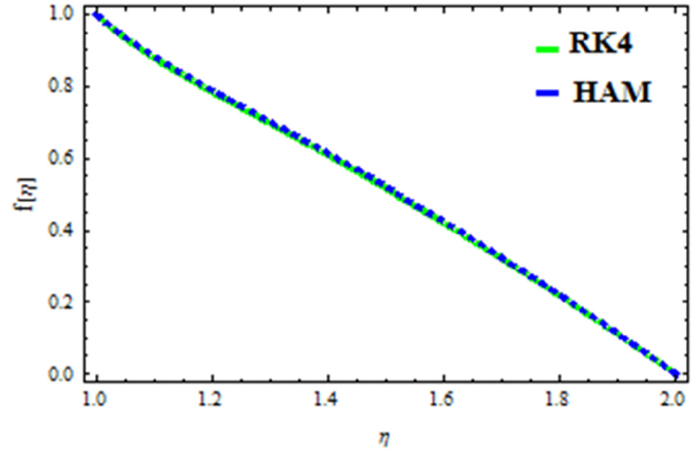
Figure 27. Comparison of RK4 and HAM for velocity in Vogel’s model.